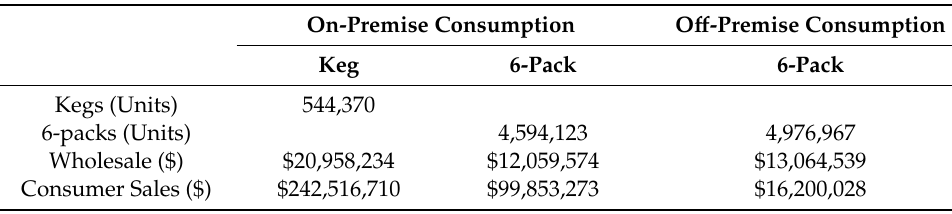
Table 2. Revenues at points of sale with no